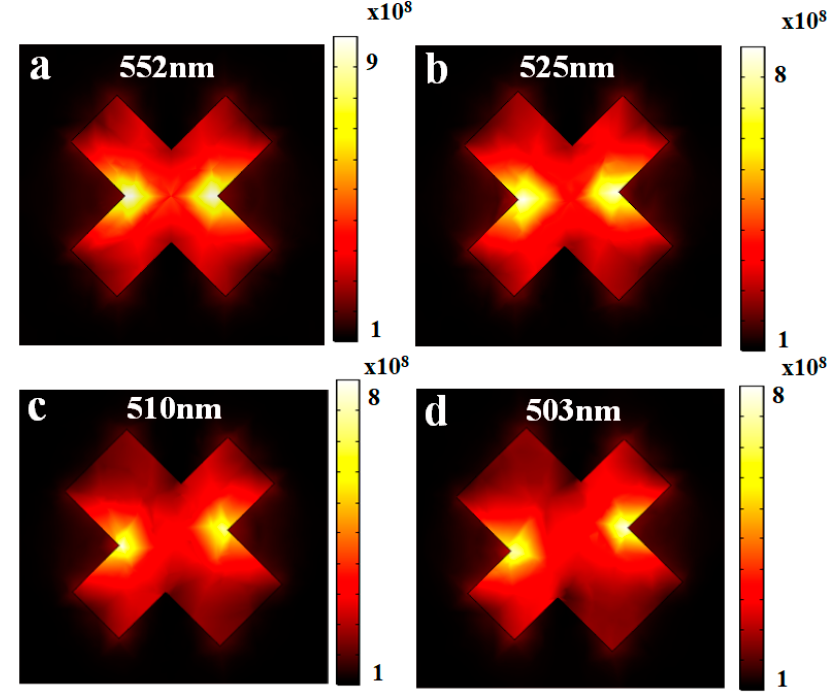
Figure 10. Electric field distribution at wavelengths 552 nm ( a ), 525 nm ( b ), 510 nm ( c ), and 503 nm ( d ) for defective structure d2.